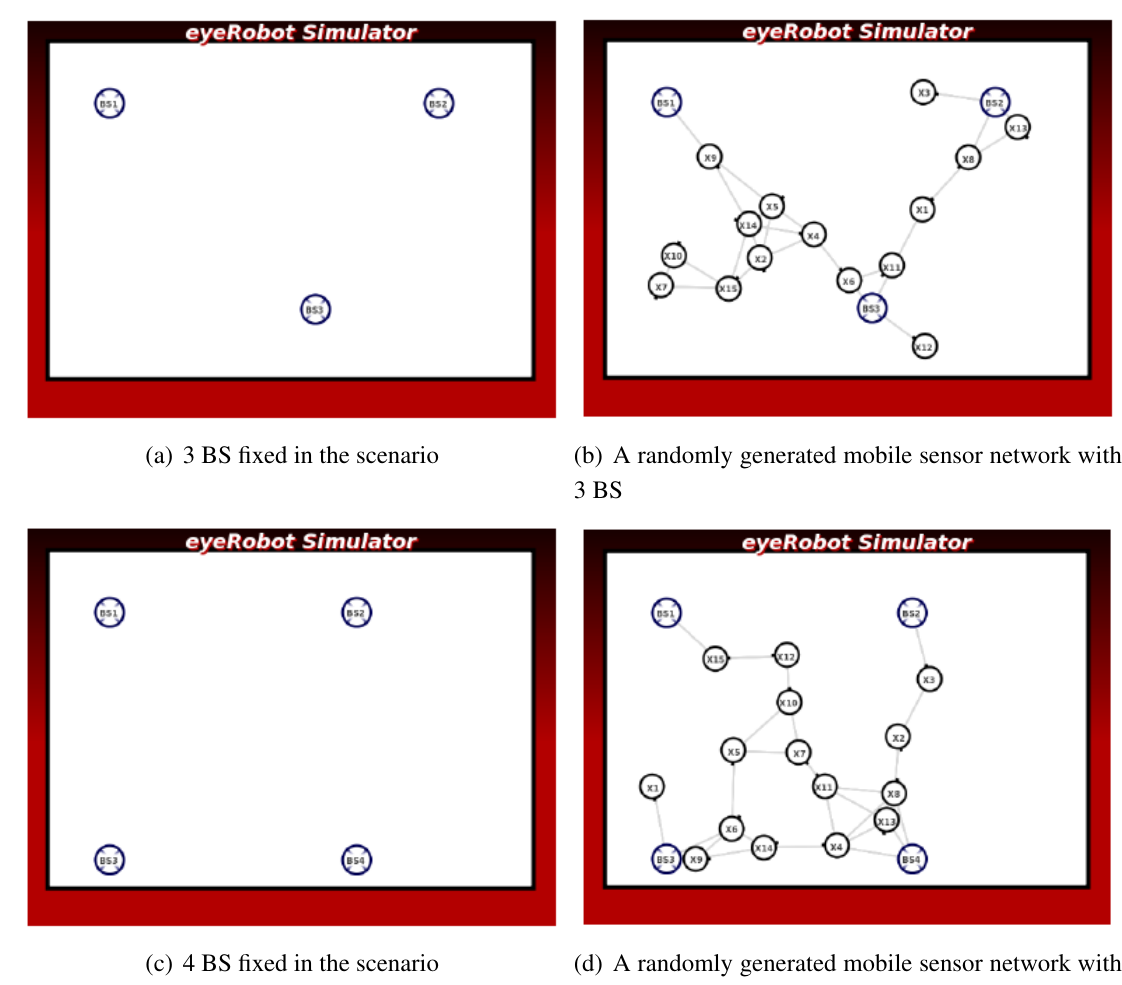
Figure 5. Two scenarios with randomly placed positions of the